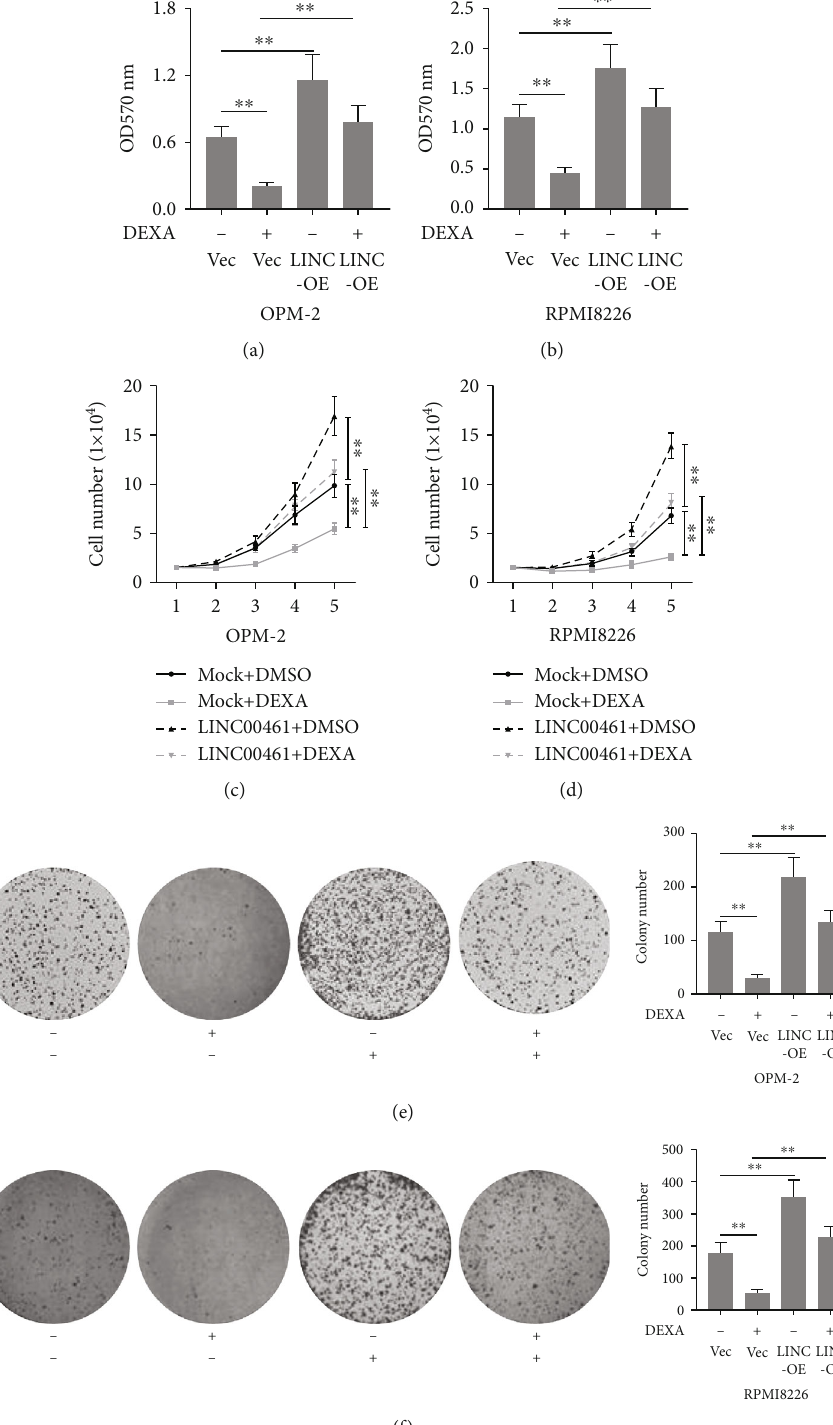
Figure 4: The overexpression of LINC00461 suppressed the inhibitory e ff ects of dexamethasone on cell proliferation. (a, b) Cells were treated with or without dexamethasone (10 μ M). After 48 hours, cell viability was determined by using the MTT assay. (c – f) In addition, cell number and colony formation assays were determined on OPM-2 and RPMI8226 cells. Mock indicates that the cells were transfected with a vector. One-way ANOVA for the data in (a), (b), (e), and (f). Two-way ANOVA for the data in (c) and (d). ∗∗ p < 0 : 01